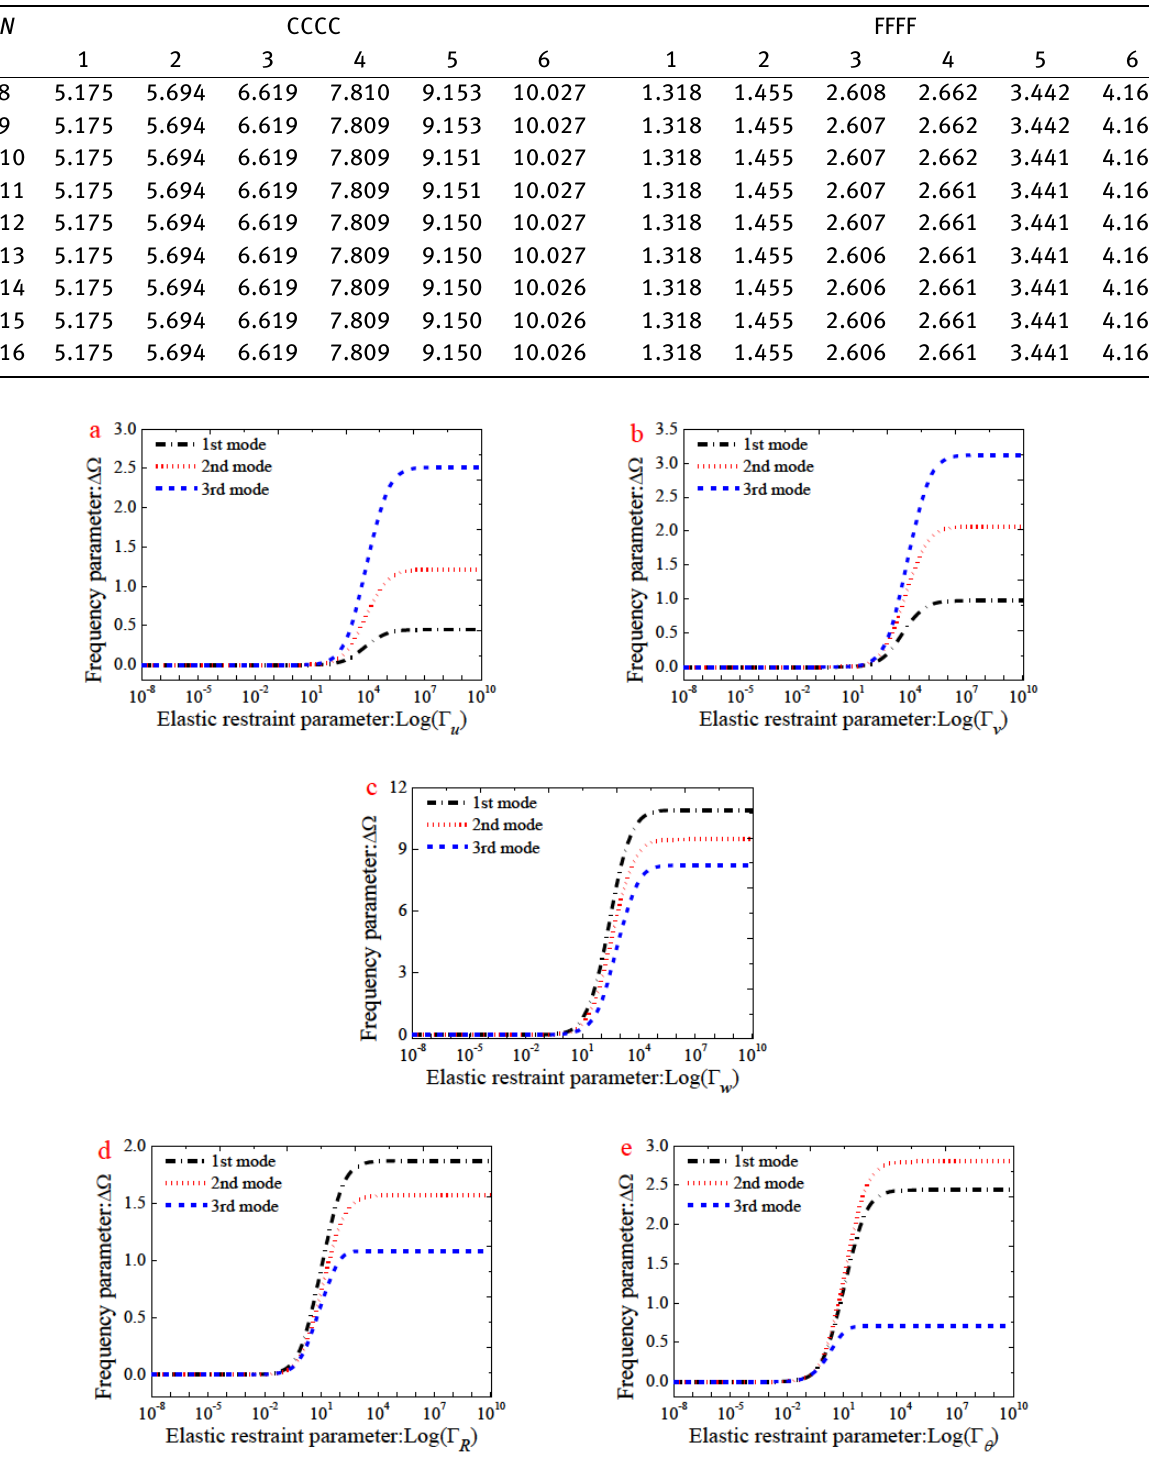
Table 1: Convergence of the first six frequency parameters for a [0 ∘ /90 ∘ ] laminated annular sector plate with CCCC and FFFF boundary con-